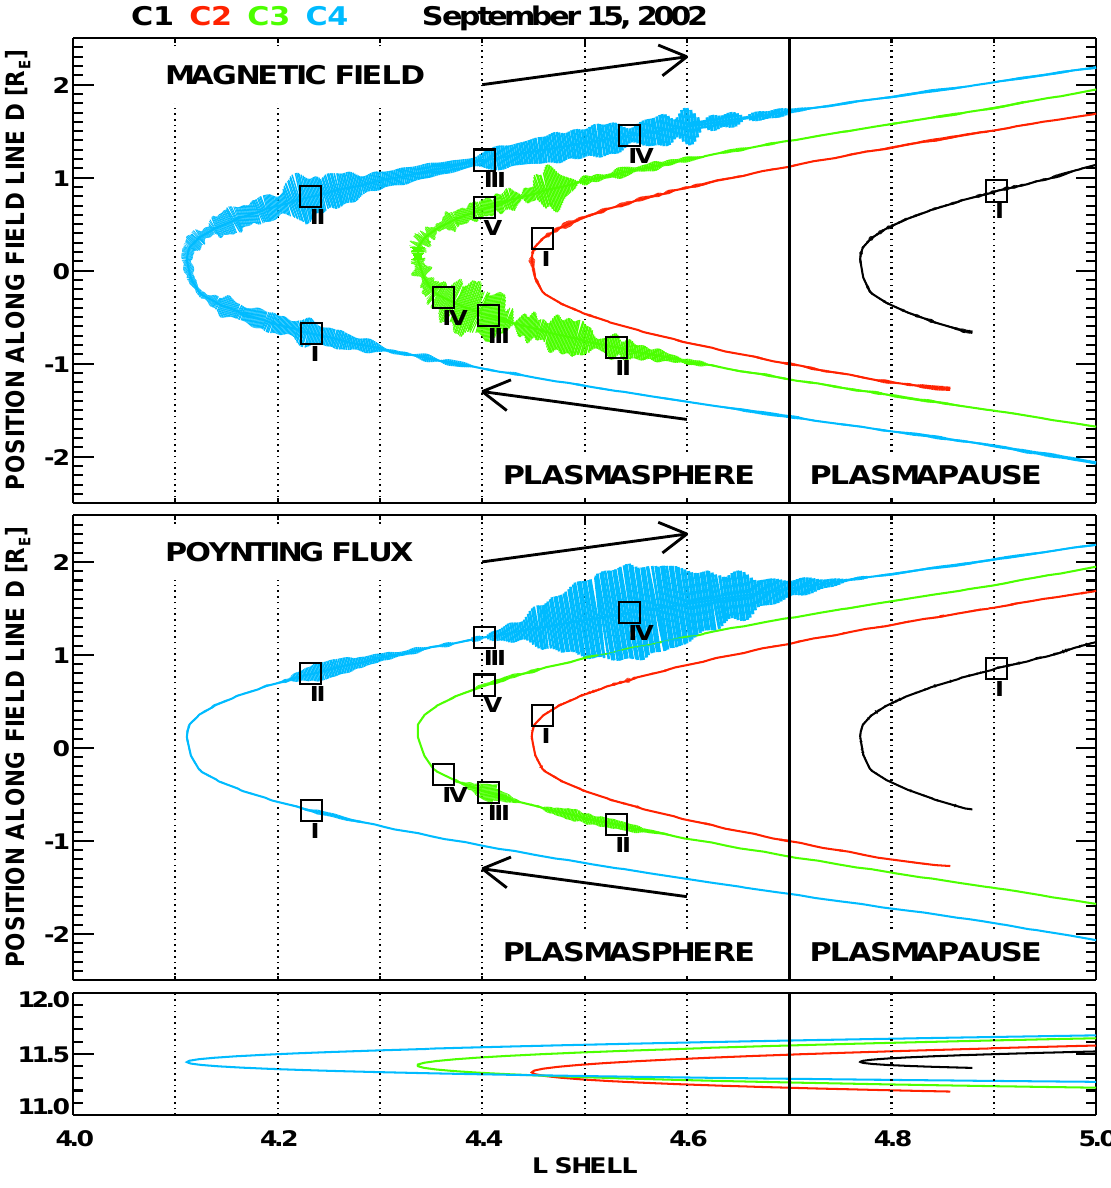
Fig. 6. Positions of the CLUSTER spacecraft in the L-D coordinate system at different times, where the squares mark the positions of each spacecraft. Time I corresponds to 06:58:38 UT, time II to 07:23:42 UT, time III to 07:30:22 UT, time IV to 07:34:22 UT and time V to 07:50:06 UT. The arrows show the flight direction of the CLUSTER satellites. The thickness of the lines are related to the amplitude of the radial oscillation of the magnetic field b r (upper panel) and the radial component of the time averaged Poynting vector h S r i (second panel). The bottom panel shows the orbit in the L-M plane, where M corresponds to the magnetic local time MLT.